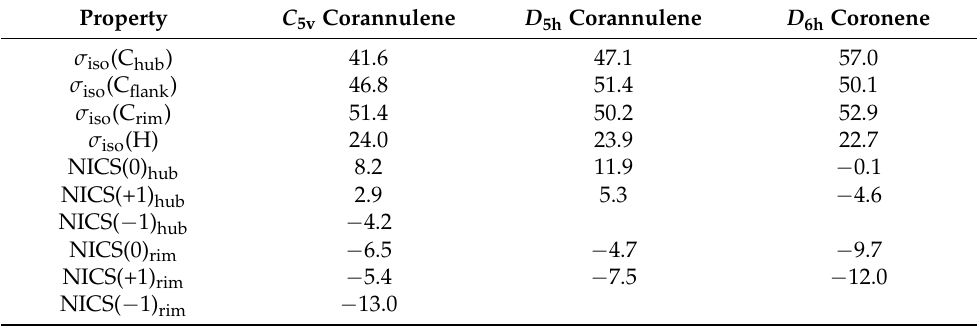
Table 1. Isotropic shieldings for all nuclei in C 5v corannulene, D 5h corannulene and D 6h coronene, as well as NICS(0) and NICS(1) or NICS( ± 1) values (in ppm) for the hub (central) and rim (peripheral) rings, calculated at the B3LYP-GIAO/6-311++G(d,p)//B3LYP-D3(BJ)/def2-TZVP level. The NICS(1) values for the two planar geometries are shown in the respective NICS(+1) hub and NICS(+1) rim rows. Property C 5v Corannulene D 5h Corannulene